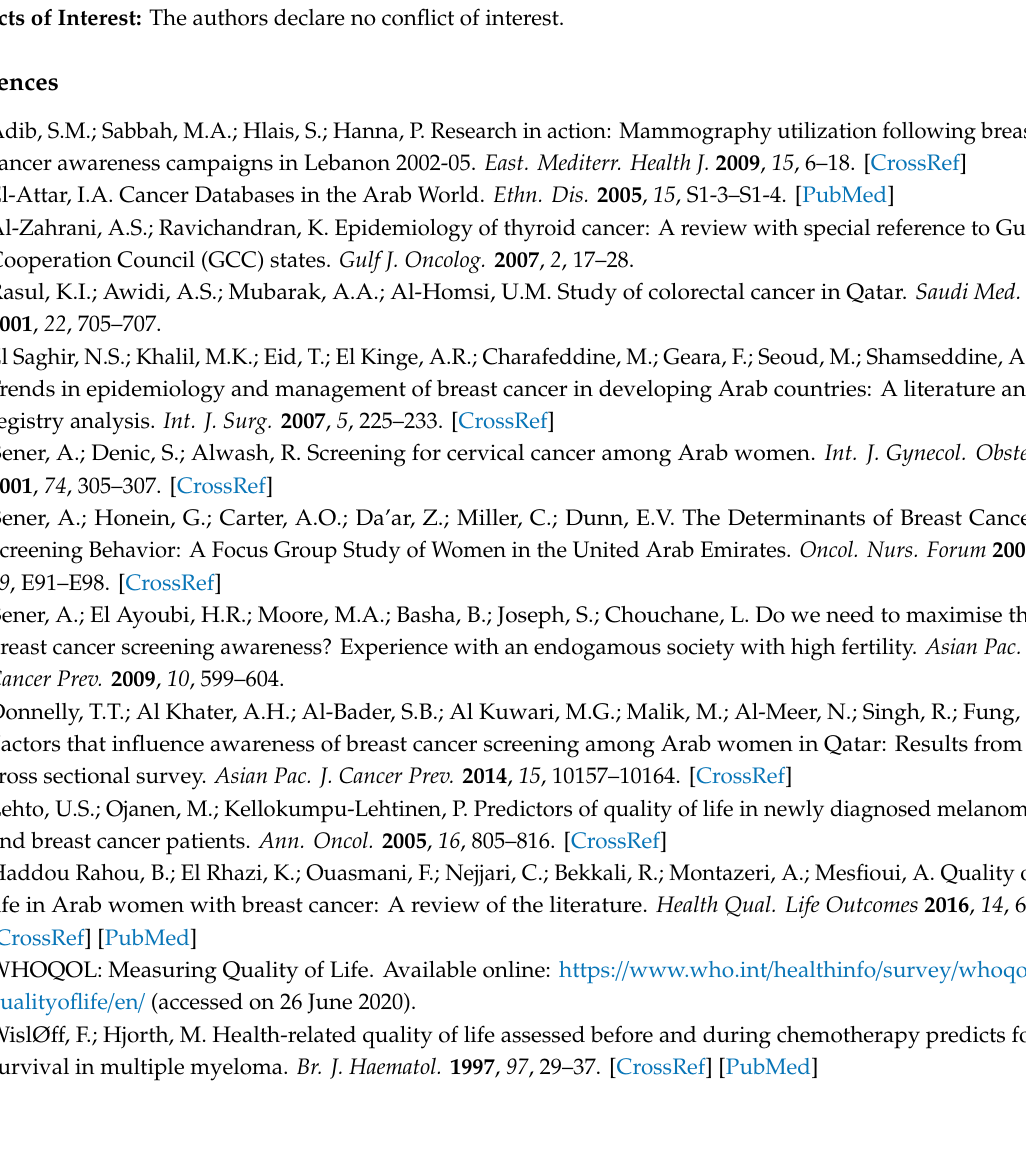
Table S1: The included